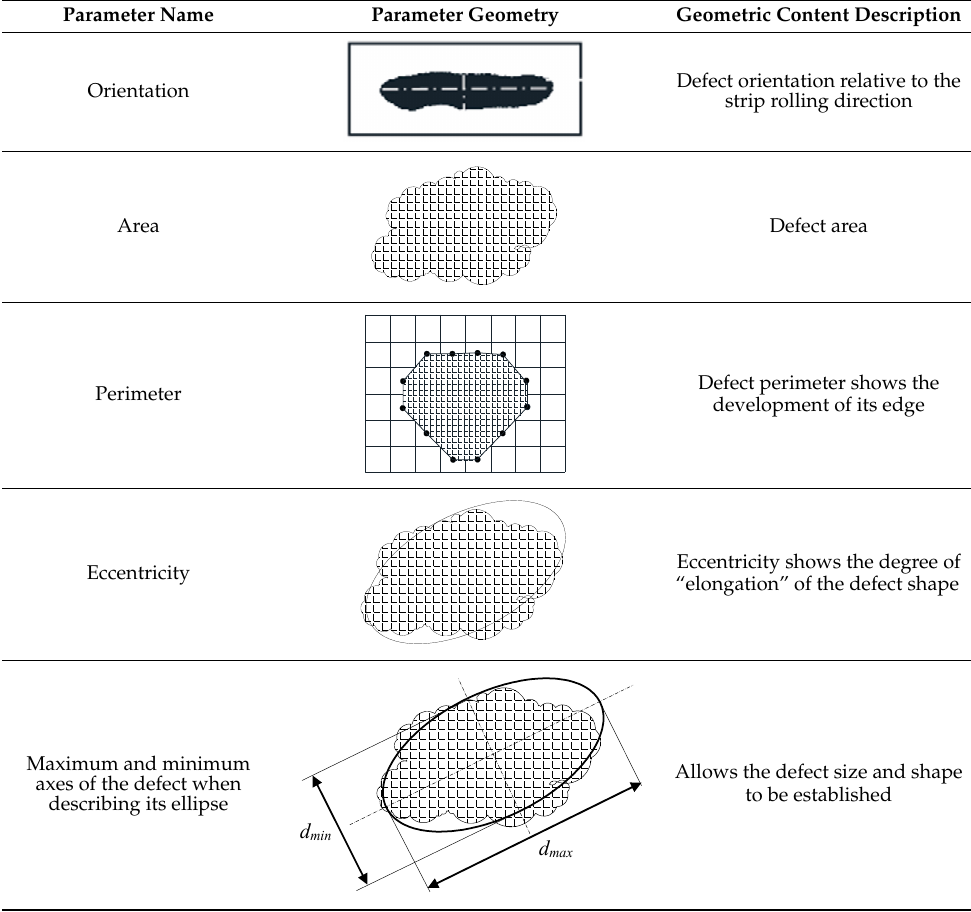
Table 3. Morphological features, causes of formation, and morphological description of defects of class “scratch, line, attrition”. Defect Subclass Causes of Formation The Scheme of the Analyzed Defects Scratches